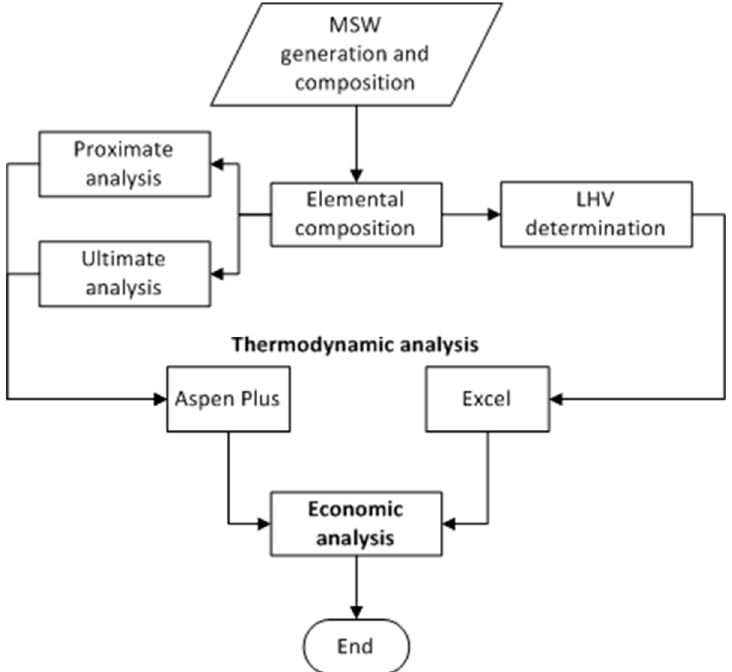
Figure 5. Methodology applied to evaluate a waste-to-energy plant in Havana.